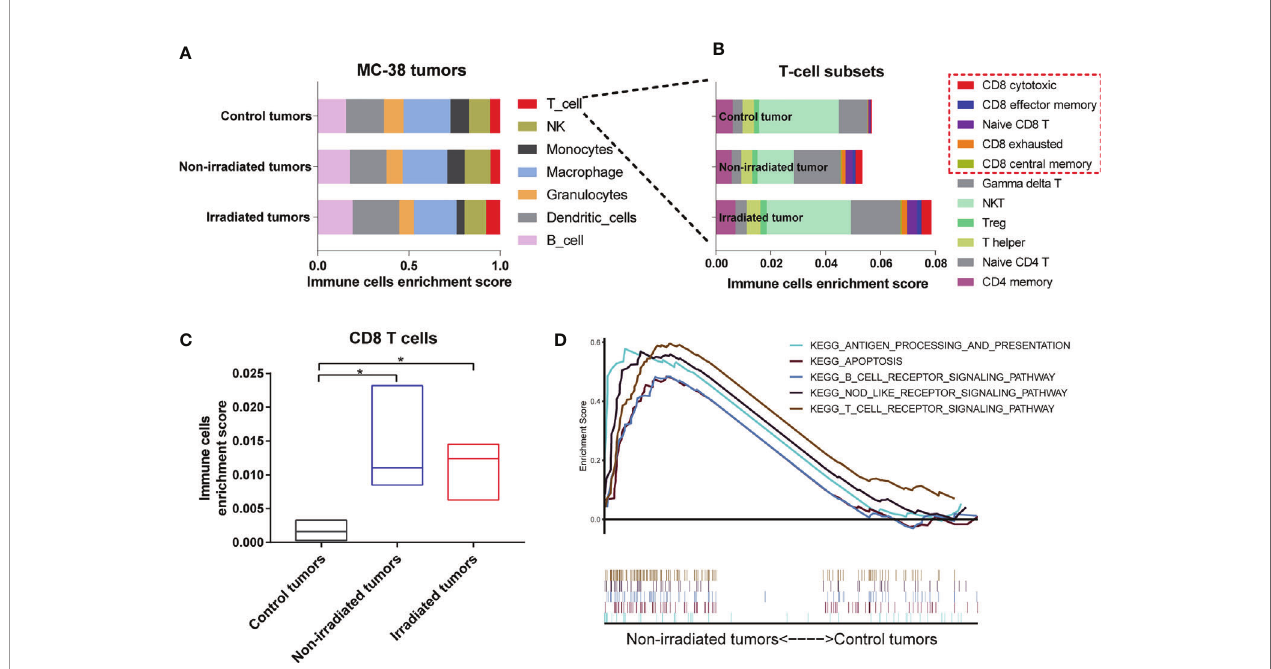
FIGURE 5 | Single high-dose radiation triggered the immune response of non-irradiated tumors in the MC38 model. (A, B) Distributions of 7 immune cell and 11 T cell subsets in the irradiated tumors, non-irradiated tumors and control tumors of the MC38 model were assessed by immune cell abundance identi fi er (immuCellAI- mouse). (C) Enrichment scores of CD8 T cells were signi fi cantly higher in both irradiated and non-irradiated tumors than in control tumors. (D) Signi fi cantly enriched KEGG pathways from the GSEA in non-irradiated tumors. *p <